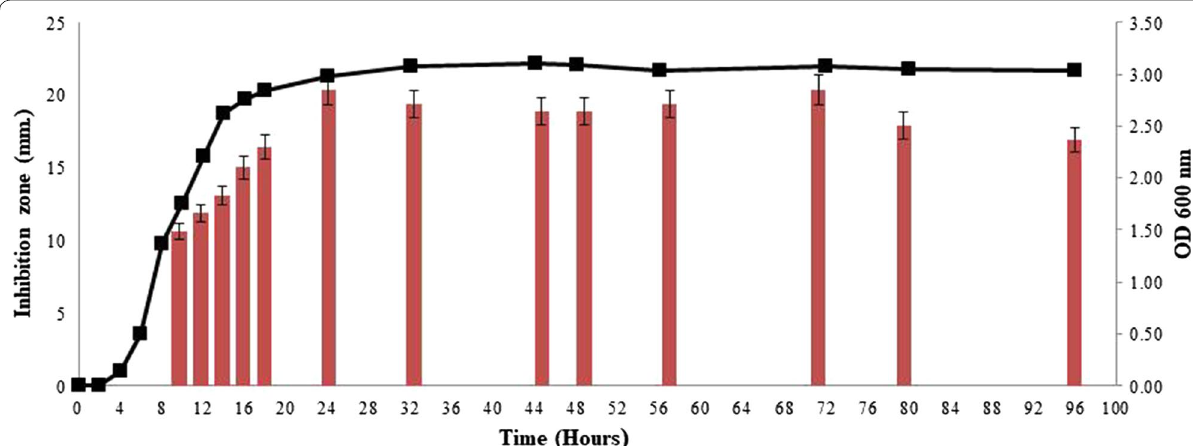
Fig. 3 The production of secondary metabolites active against B. pseudomallei from B. amyloliquefaciens KKU1 in a time course manner. The production of secondary metabolites displayed as sizes of the inhibition zones in nm against B. pseudomallei are plotted on the left Y axis and growth curve as measured by OD at 600 nm are plotted on the right Y axis. The X axis represents the time in